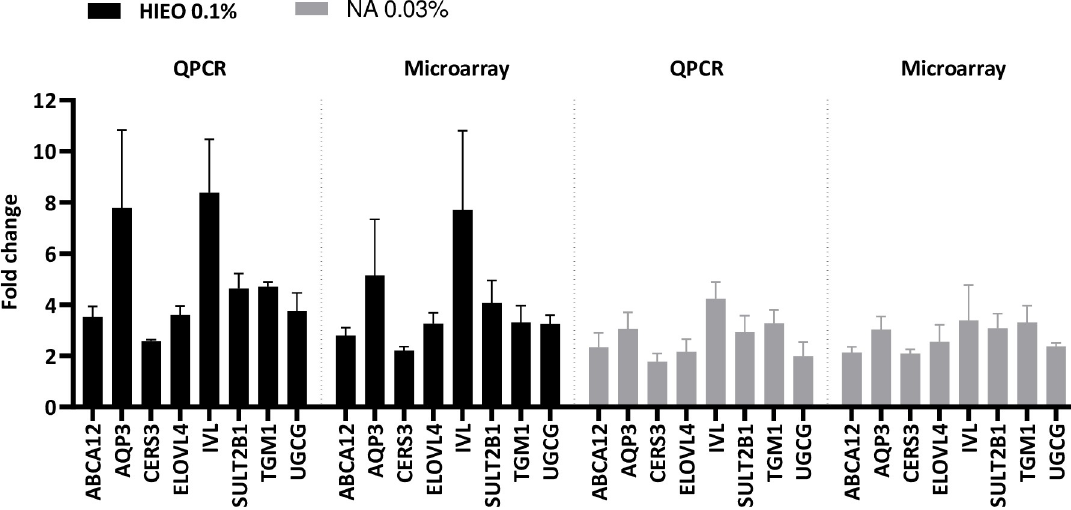
Fig 4. QRT-PCR confirms HIEO and NA changes identified in microarray expression data. Results indicate relative gene expressions of HIEO- (0.1%) or NA-treated skin (0.03%) compared to the control DMSO (0.5%). QRT-PCR results for a subset of genes identified as skin barrier ( AQP3 , IVL , TGM1 ), ceramide biosynthesis ( ABCA12 , CERS3 , ELOVL4 , UGCG ), and cholesterol metabolism ( SULT2B1 ) validated the microarray expression data for skin explants. Data, from 3 individuals in quadruplicate for each donor, are expressed as the gene of interest corrected by the geometric mean of POLR2A, GAPDH and TBP and are the mean ± standard error.